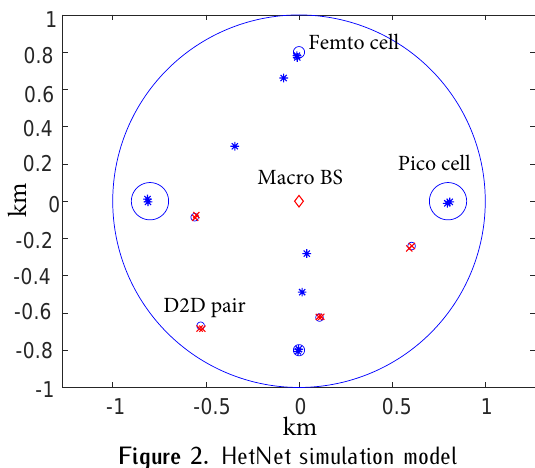
Figure 2. HetNet simulation model The equality holds when only D2D pair j commu- nicates and other D2D pairs do not transmit data.